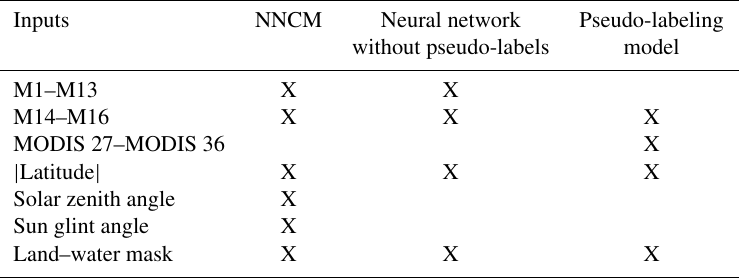
Table 3. Summary of the inputs included in the three neural networks used in this work. See the main text for description of each